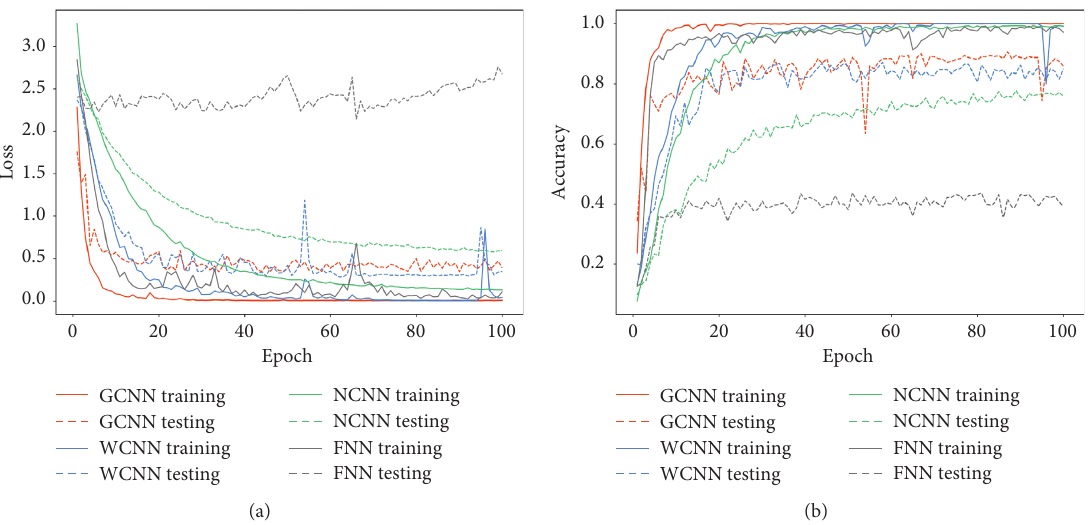
Figure 9: Loss and accuracy curves of the models in experiment 1 with sixteen classes. (a) Loss. (b)